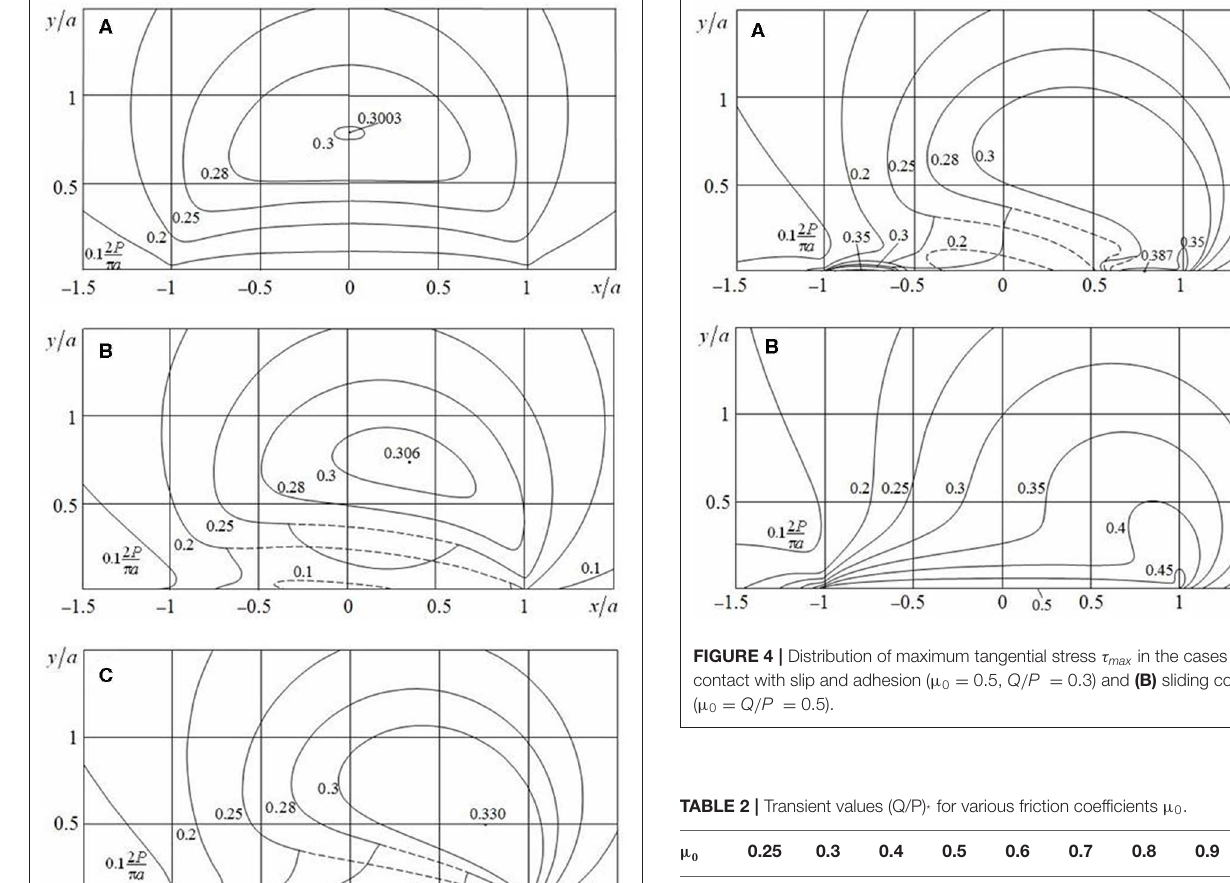
TABLE 2 | Transient values (Q/P) * for various friction coefficients µ 0